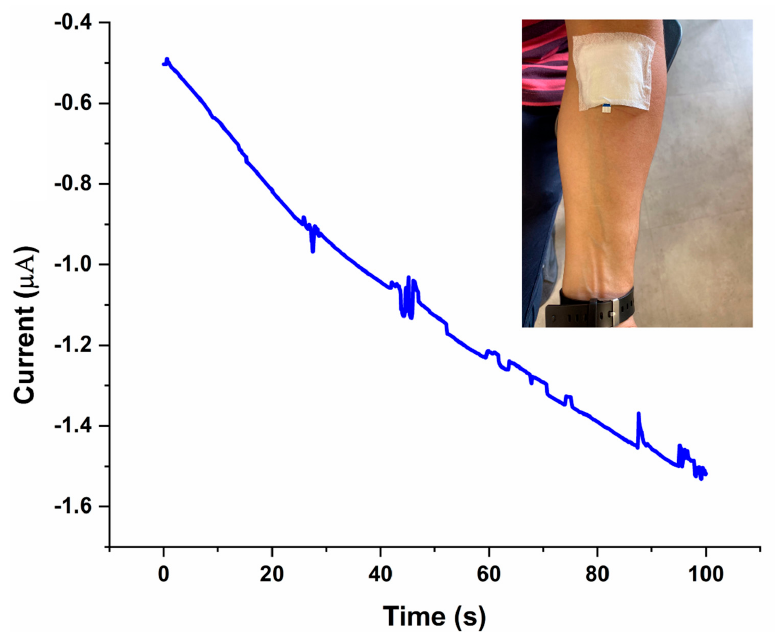
Figure 9. On-body measurement of glucose in sweat with the 3D PMED.